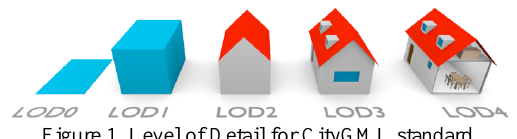
Figure 1. Level of Detail for CityGML